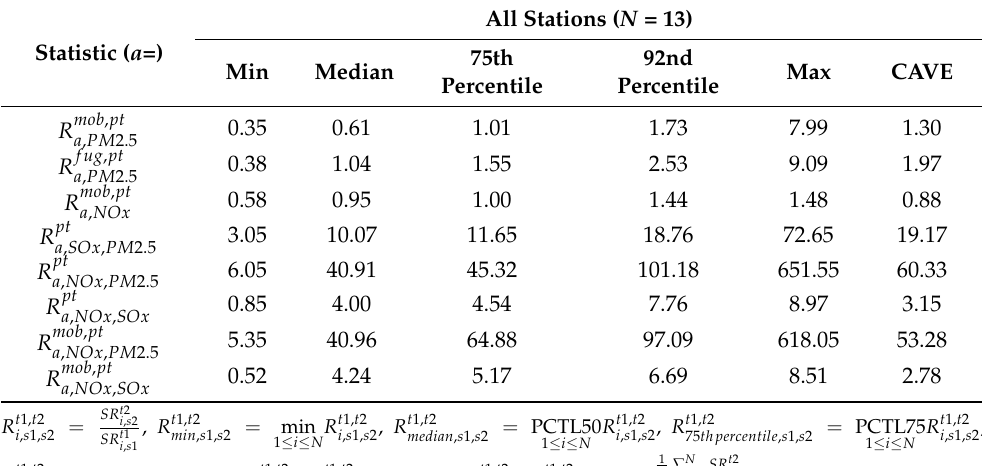
Table 4. Distribution of offset ratios over the stations in